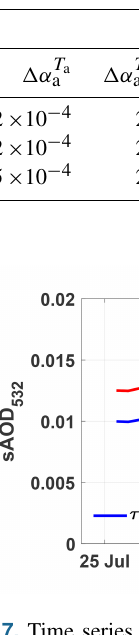
Figure 7. Time series of stratospheric AOD (sAOD 532 ) for Fair- banks for τ a (532 ,z ) and τ T a a (532 ,z